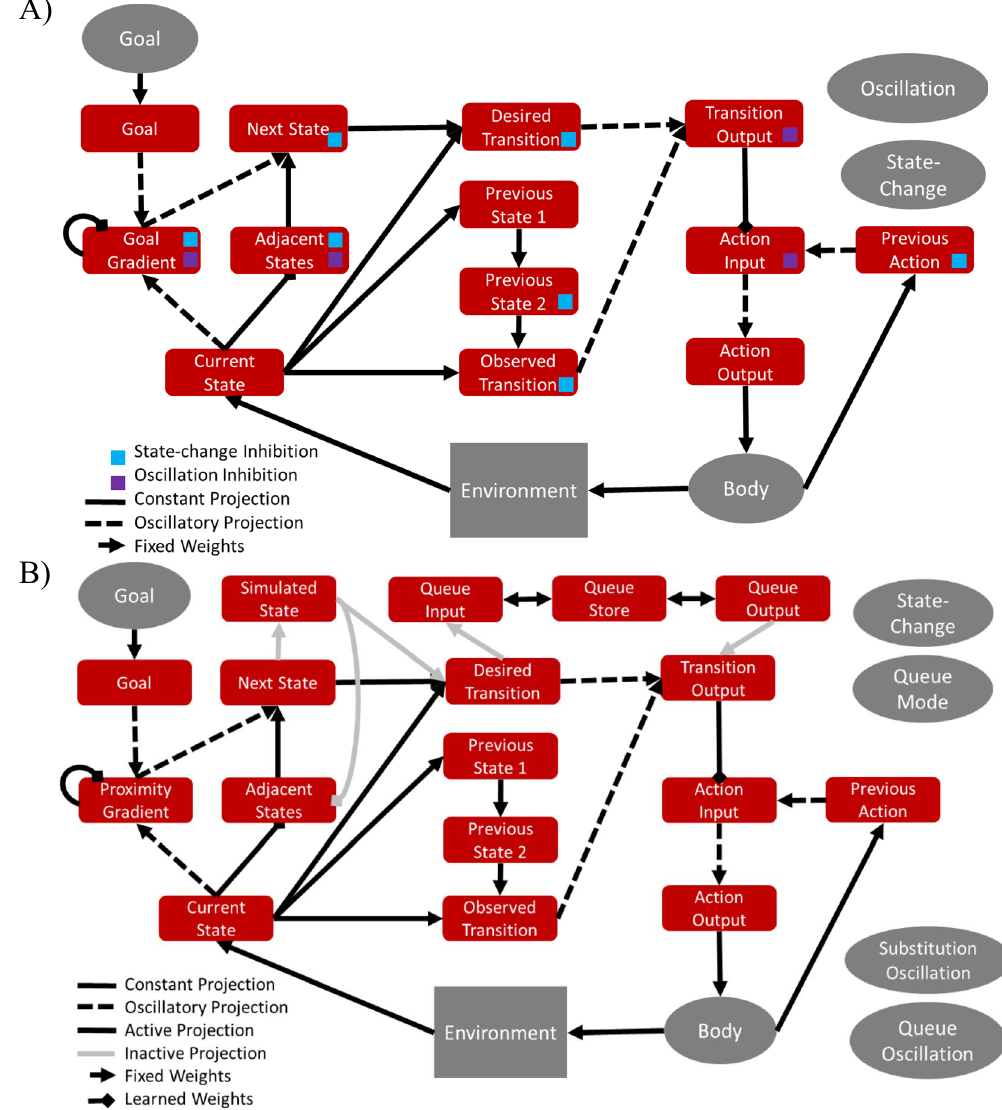
Figure 5. ( A ) Full diagram of core model. Each rectangle represents a layer and each arrow a projection. The body is a node, and two additional nodes are not shown which provide inhibition at each state-change and oscillatory control. The colored squares indicate which layers receive inhibition from these nodes. Some recurrent connections not shown. ( B ) Full diagram of extended model, with added top row representing ability to plan multiple state transition steps ahead (Simulated State, Queue Input, Queue Store, and Queue Output layers). Adapted with permission from earlier work 34